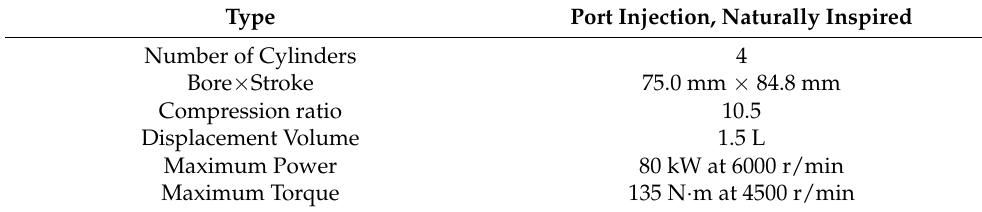
Table 2. Main parameters of the test engine.